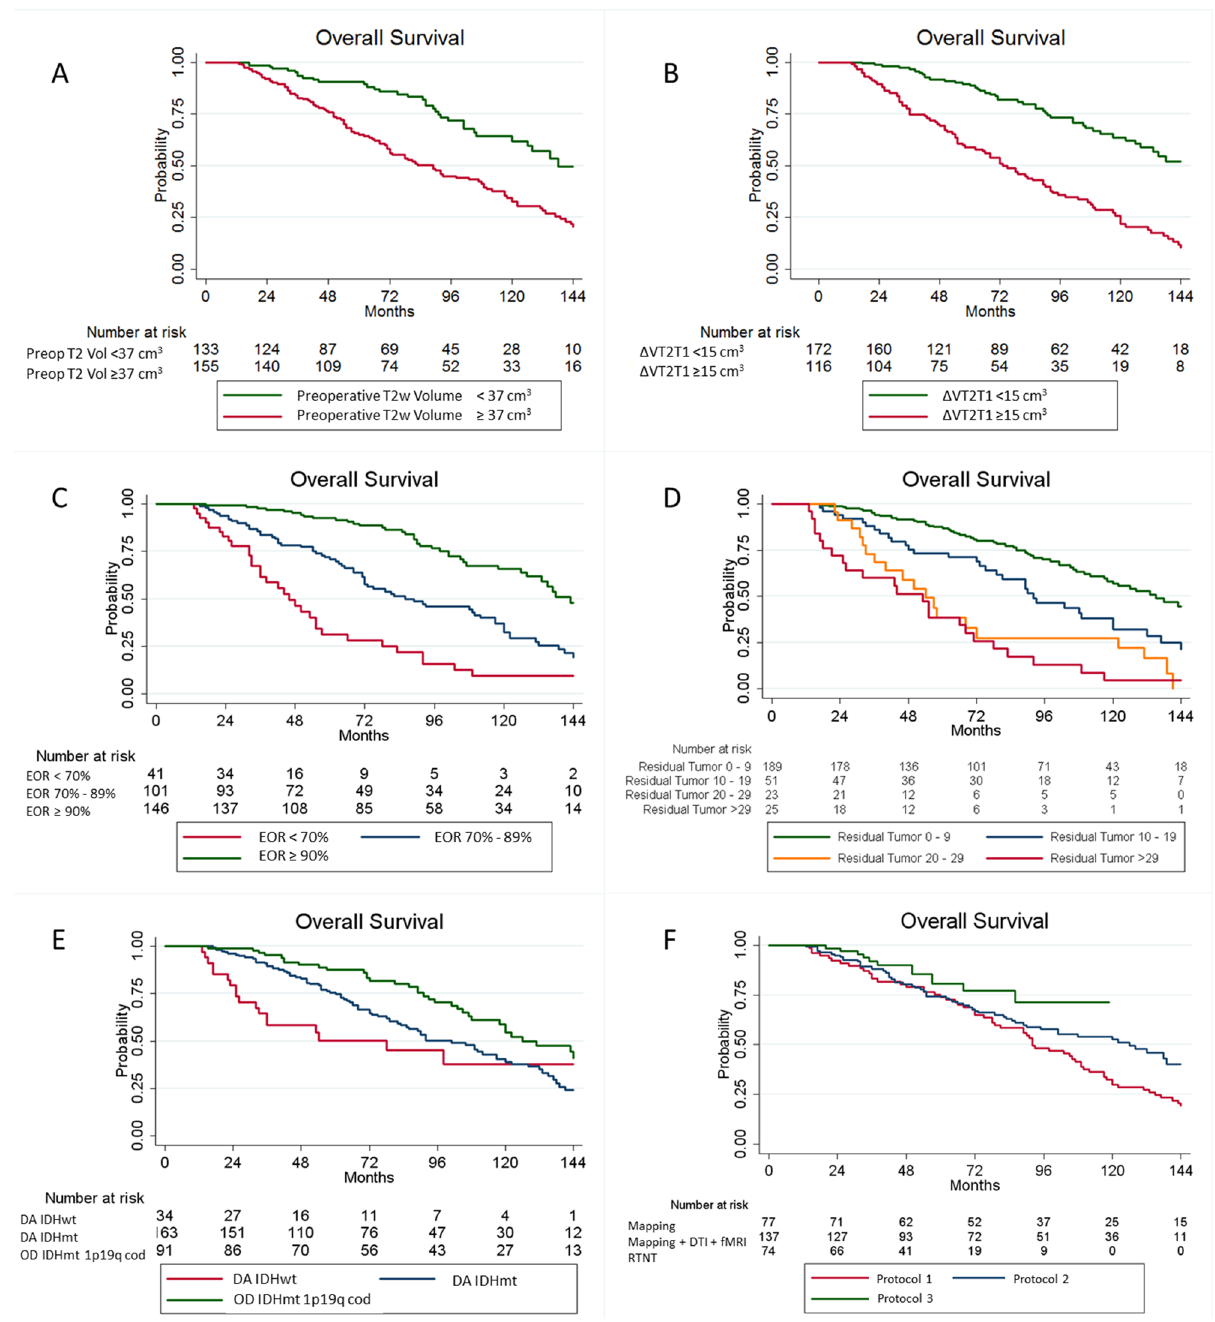
Figure 2. Kaplan–Meier curves displaying overall survival (OS) according to the preoperative tumor volume ( A ), preoperative tumor growing pattern, as expressed by ΔT2T1 ( B ), extent of resection ( C ), intraoperative protocol ( D ), residual tumor ( E ) and molecular class ( F ). Preop T2 Vol preoperative tumor volume computed on T2-weighted images, ΔT2T1 preoperative tumor volume segmented on T2-weighted MRI images – preoperative tumor volume segmented on T1-weighted images, EOR extent of resectionm DA IDHwt Diffuse Astrocytoma Isocitrate Dehydrogenase wild type, DA IDHmt Diffuse Astrocytoma Isocitrate Dehydrogenase mutated, OD IDHmt 1p19q cod Oligodendroglioma Isocitrate Dehydrogenase mutated, 1p 19q